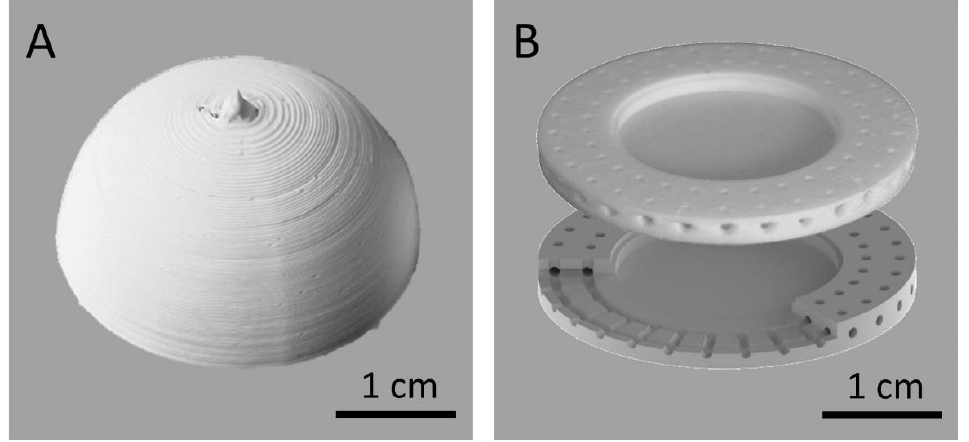
Figure 5. Two successfully printed three-dimensional structures with pronounced overhangs. ( a ) a half-sphere with a wall thickness of three lines is shown, which has an outer diameter of 3 cm. ( b ) implant housing with an inner cavity and surrounding embedded channels with a diameter of 1 mm (Top: 3D-printed ceramic after sintering; Bottom: drawing).